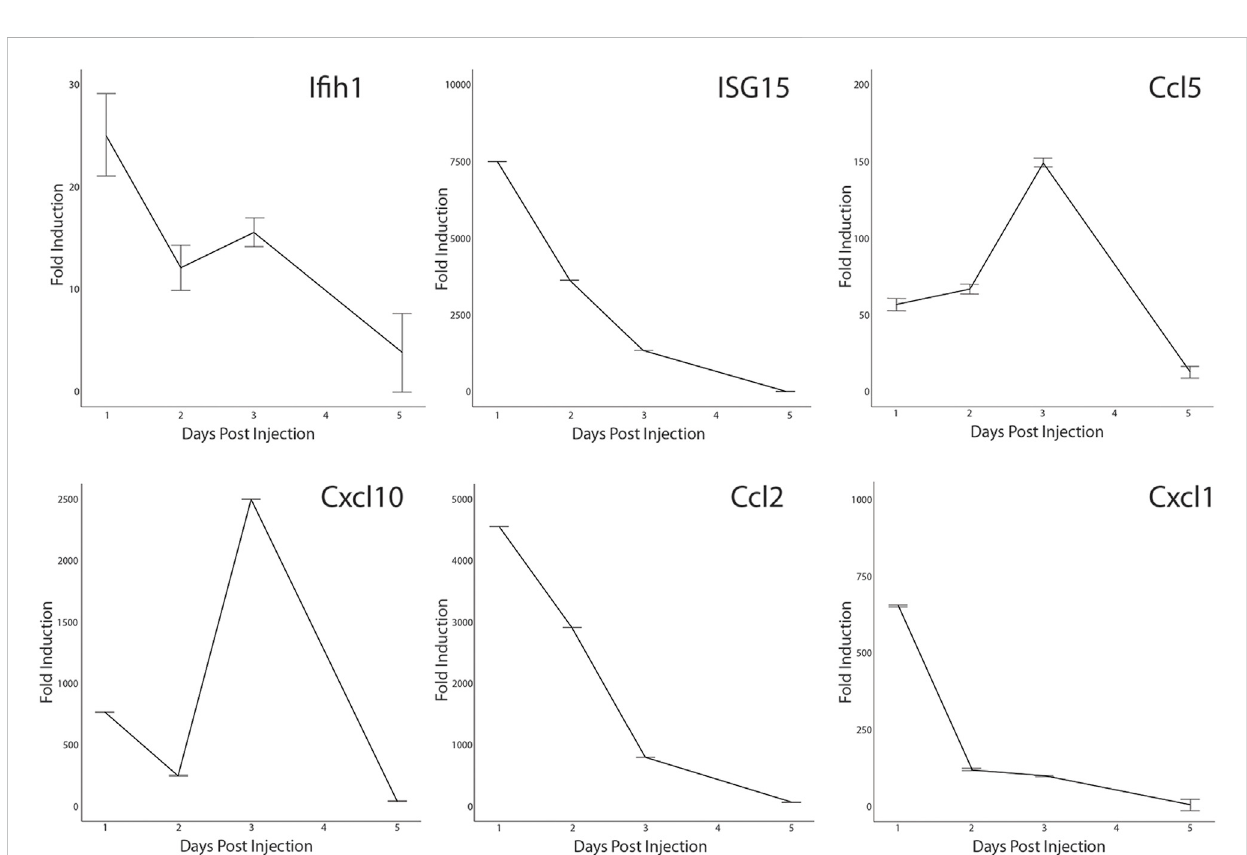
FIGURE 8 Transcription of antiviral interferon pathway genes in CTX-injured quadriceps. CTX-injured quadriceps had total RNA isolated at 1, 2, 3, and 5 DPI. Transcripts of I fi h1, Isg15 , Ccl5, Cxcl10, Ccl2 , and Cxcl1 were quanti fi ed by RT-qPCR. RNA transcript levels are expressed as the fold induction over RNA isolatedfromtheuninjuredcontralateralleg.Signi fi cancewasdeterminedbyStudent ’ st-test,alltimepoints p < 0.0001exceptfor Cxcl1 , I fi h1 ,and Ccl5 at 5